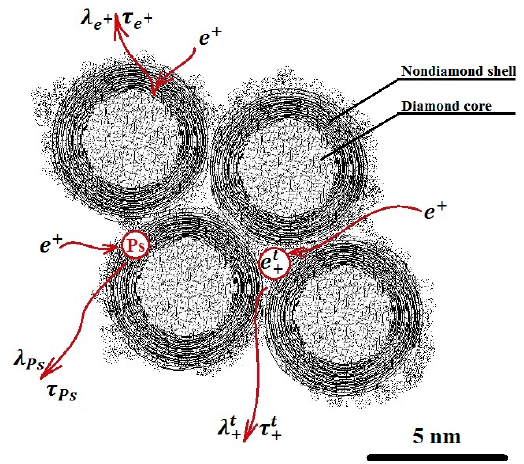
Figure 2. Model of delayed formation of positronium in nanodiamonds.